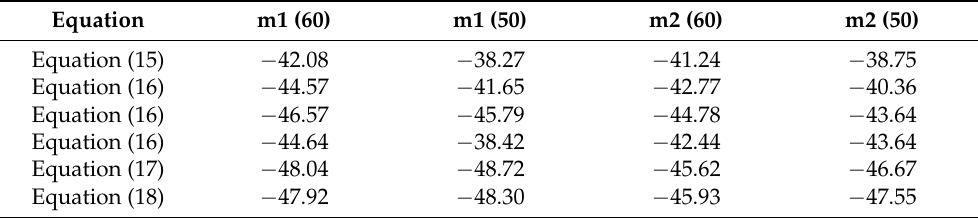
Table 3. The values of the standard Gibbs free energy of adsorption (kJ/mol) of FC1 and FC2 (Equations (15) and (16)) and this energy for the mixtures (Equations (17) and (18)). Equation m1 (60) m1 (50) m2 (60) m2 (50) Equation (15) − 42.08 − 38.27 − 41.24 − 38.75 Equation (16) − 44.57 − 41.65 − 42.77 − 40.36 Equation (16) − 46.57 − 45.79 Equation (16) − 44.64 − 48.04 Equation (18) − 47.92 − 48.30 − 45.93 −